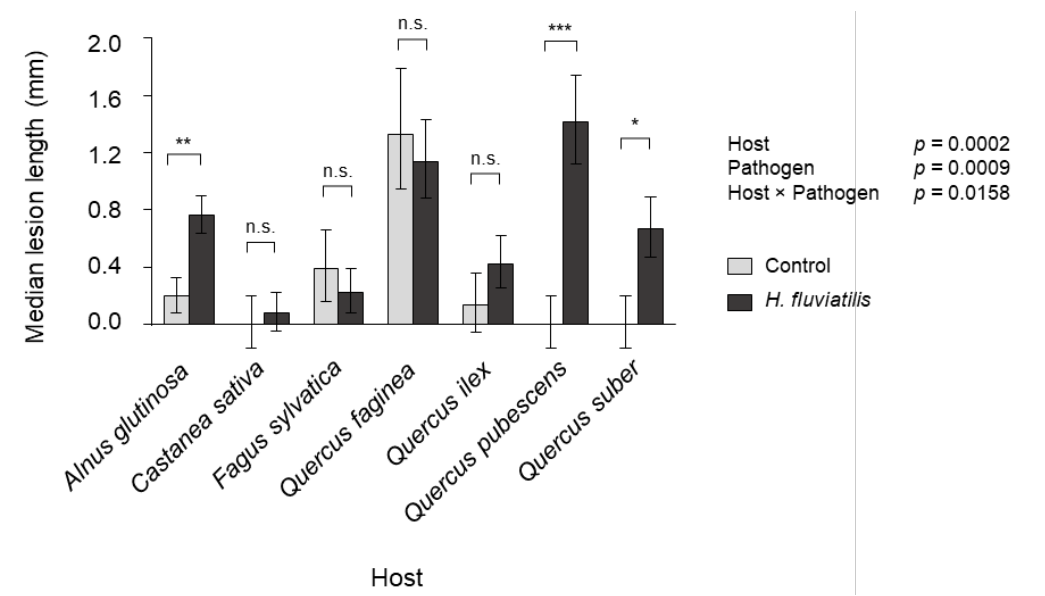
Figure 2. Pathogenicity of H. fluviatilis in Alnus glutinosa and Fagaceae species measured as lesion length 7 weeks after stem inoculations. Asterisks depict significant differences (* p < 0.05, ** p < 0.01, *** p < 0.0001). “n.s.” indicates non-significant differences at p < 0.05. Error bars represent SE.